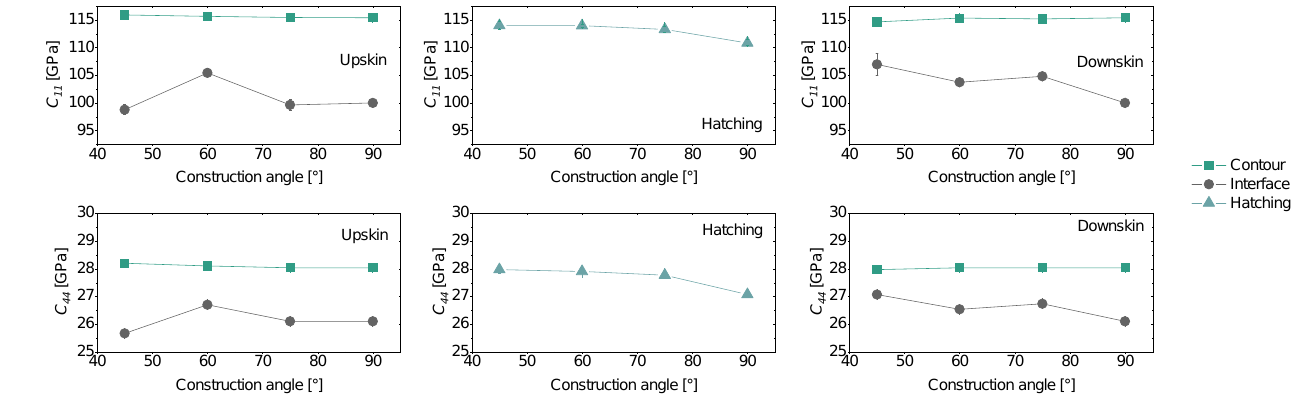
Figure 14. The effective elastic properties in each of the three characteristic regions for samples manufactured under different construction